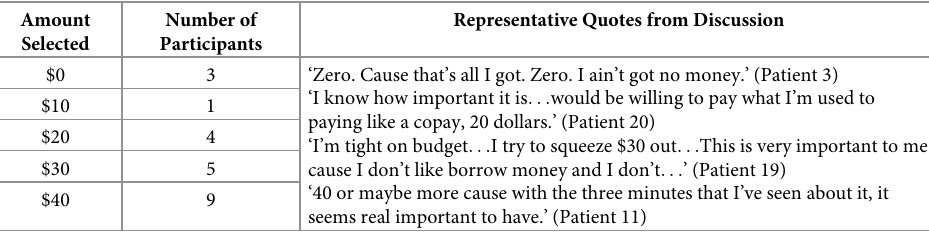
Table 3. Willingness to pay for teleophthalmology exam during a primary care provider office visit